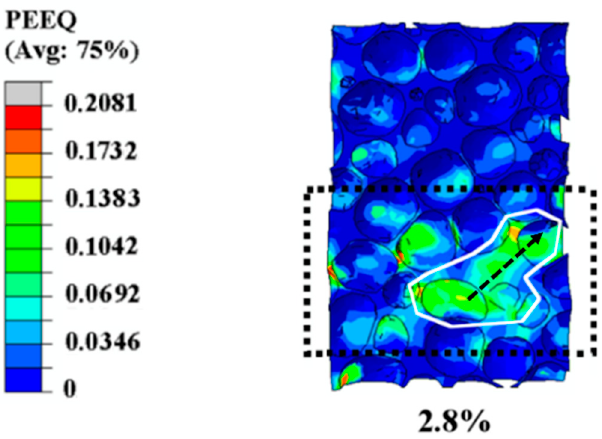
Figure 5. Illustration of the propagation of the plastic strain band at strain level 2.8%.